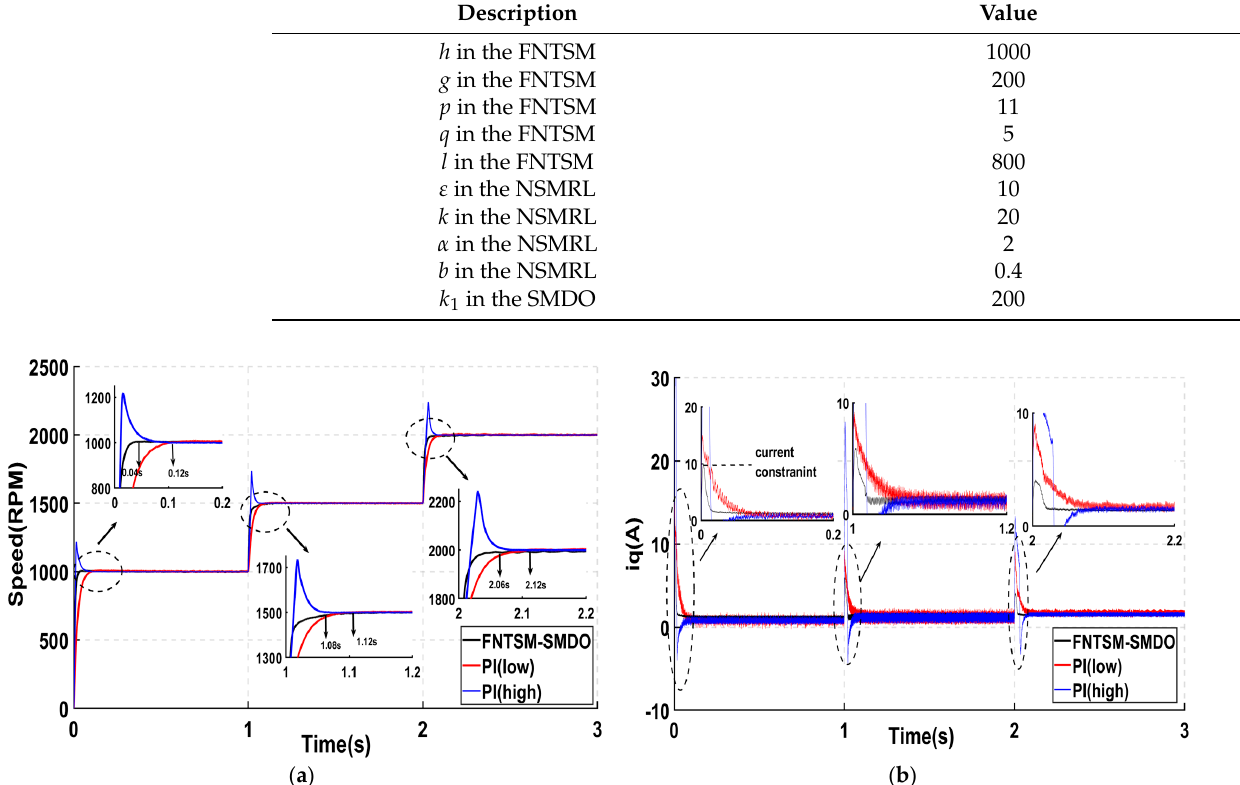
Figure 3. The xPC–Target-based hardware in the loop. Table 2. Parameters of the controller.